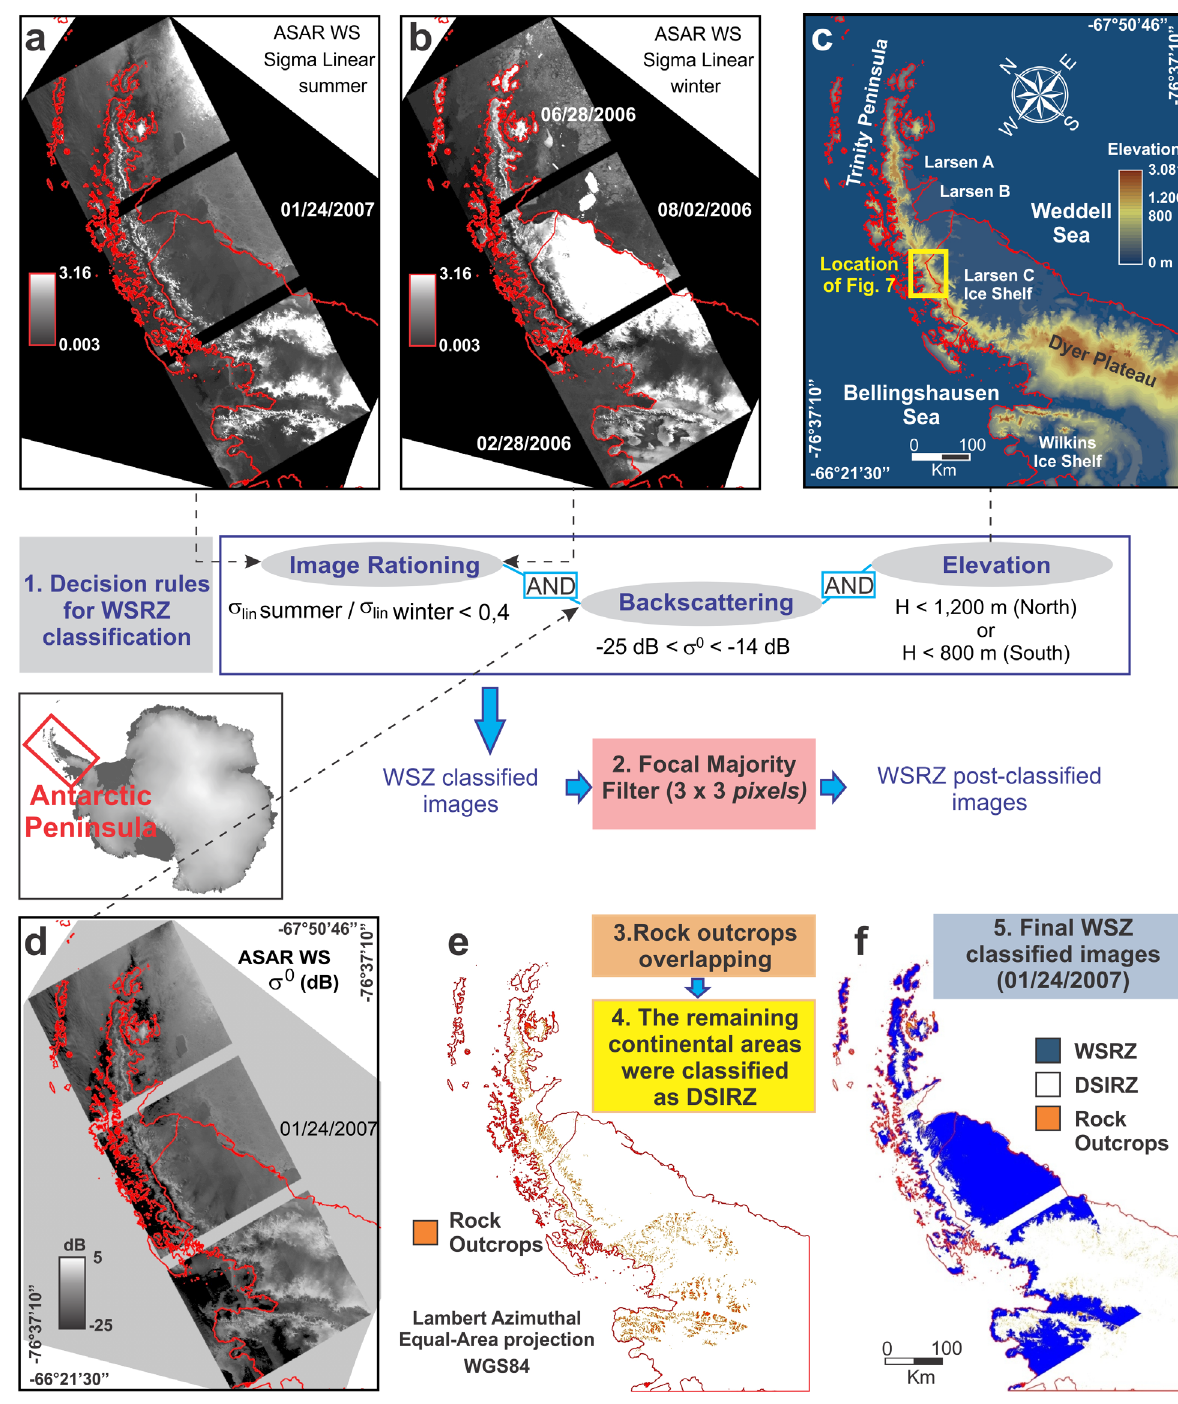
Figure 3. Snowmelt retrieval algorithm for the Antarctic Peninsula using ASAR images. In this example, we describe the classification of images acquired on January 24th, 2007. The Wet Snow Radar Zone (WSRZ) classified image was post-processed by a focal majority filter with 5 x 5 pixels and then overlapped by a rock outcrops image derived from the Antarctic Digital Database. The unclassified continental areas were assigned to Dry Snow and Ice RADAR Zones (DSIRZ), which comprises the Dry Snow Radar Zone, Frozen Percolation Radar Zone and Bare Ice Radar Zone. The location of image subsets from Figure 7 is indicated by a yellow